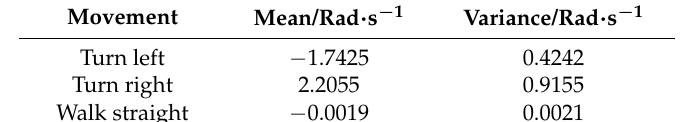
Table 1. The statistical result of angular velocity of three movements.